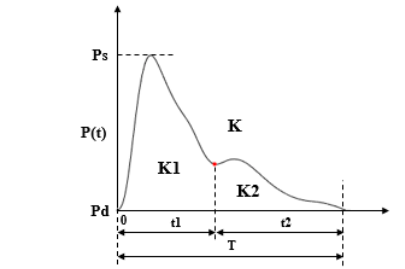
Figure 5. Extracted features.